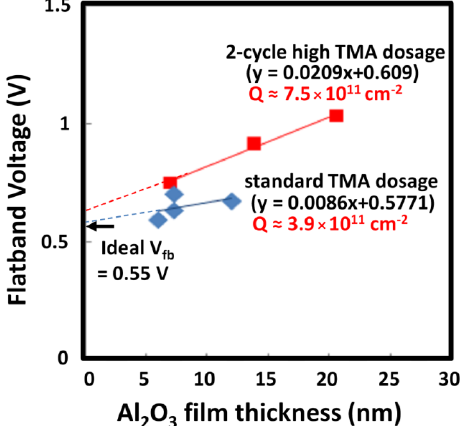
Figure 6. Dependence of the flatband voltage V from the 1 MHz C-V curves of the Au/Al indicates the fixed charge density.